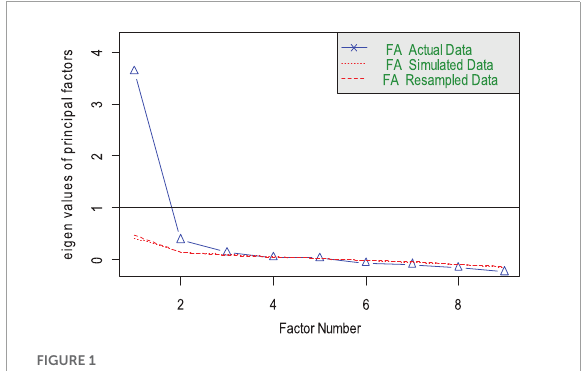
FIGURE1 Parallel analysis scree plots of the HCBS